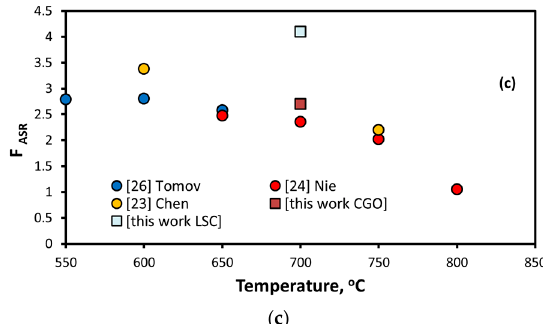
Figure 7. ( a ) I–V and I–P curves measured at 700 °C for the infiltrated and the reference cells; ( b ) relevant Nyquist plots at 700 °C (open points mark frequency decades between 10 6 and 1 Hz); ( c ) A comparison of the F ASR values reported here with the ones published previously as a result of similar infiltration experiments.